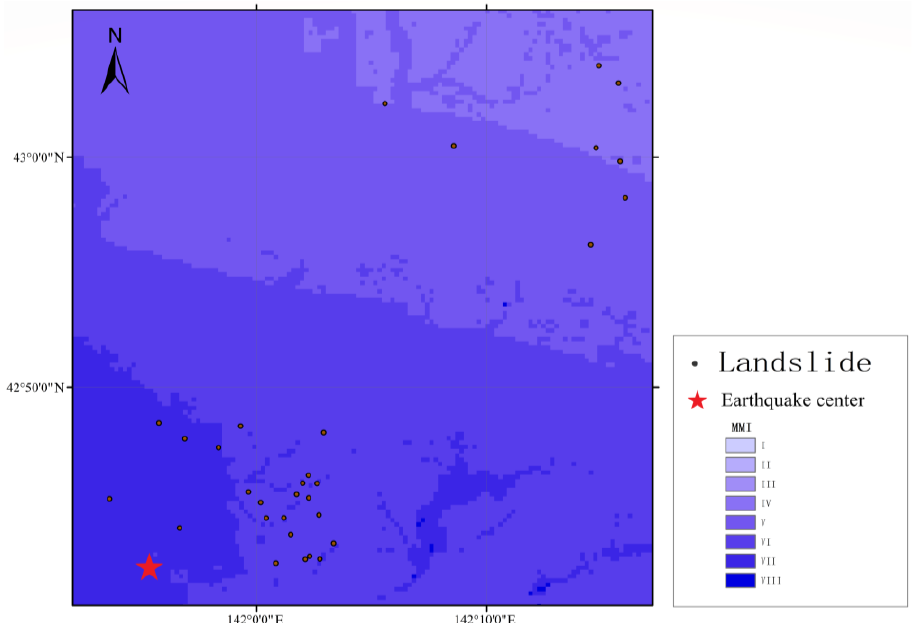
Figure 13. Modified Mercalli Intensity (MMI) and the distribution of slow-moving landslides after the earthquake.